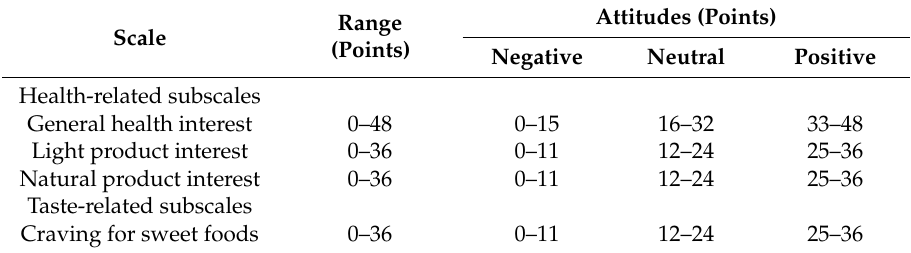
Table 1. Categories and scoring of attitudes within Health and Taste Attitudes Scale (HTAS)